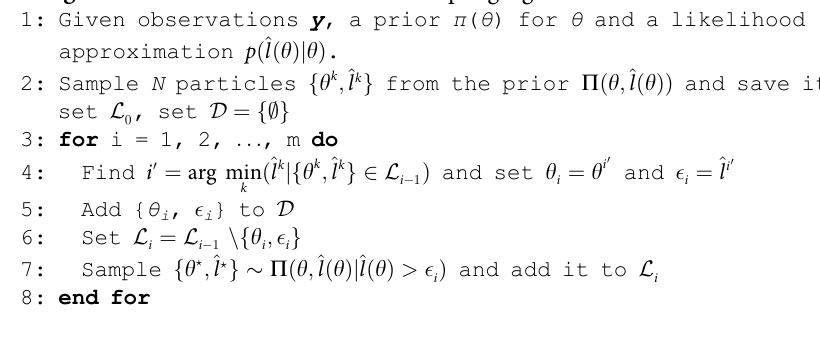
Algorithm 1 : Likelihood-free nested sampling algorithm